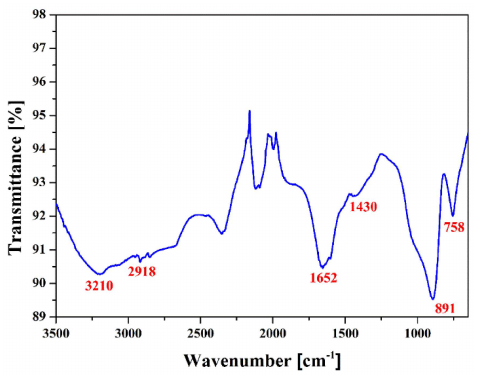
Figure 6. Fourier transform infrared spectroscopy (FTIR) spectrum of pPANI NwN thin film prepared using